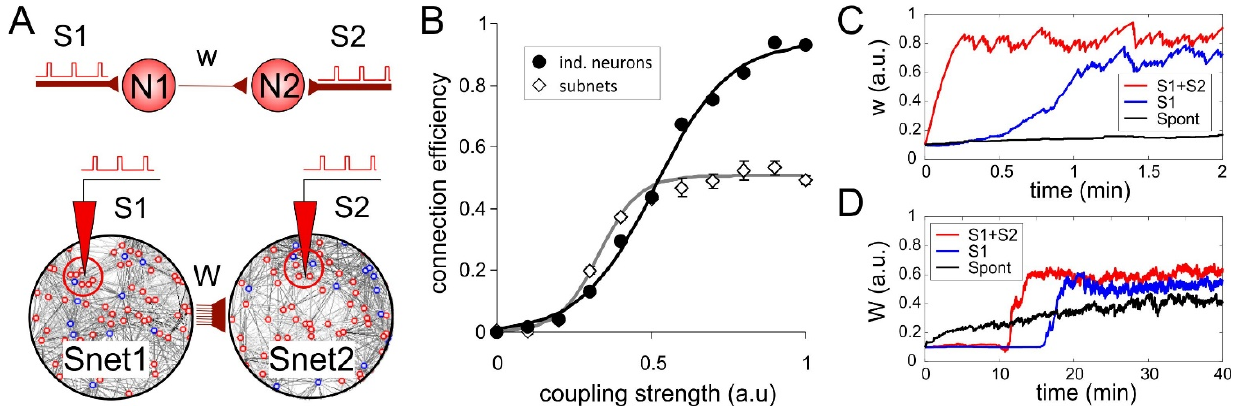
Figure 2. Quantification of interneuron couplings in single neurons and network structures. ( A ) Two model architectures with unidirectionally coupled individual neurons ( top ) and subnets by ten projecting axons ( bottom ). ( B ) The connection efficiency (bursts “passing” from one structure to the other) vs. coupling weight (for subnets the average weight is used). ( C ) Self-reinforcement of the coupling weight for individual neurons in spontaneous conditions (Spont), under stimulation of the presynaptic neuron (S1), and paired stimulation (S1 + S2). ( D ) The same as in ( C ) but for the subnets.